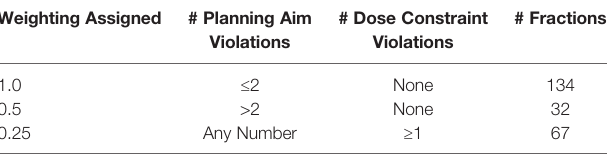
TABLE 1 | Treatment fraction data weighting regime utilized in the model training process and the number of data points belonging to each category. Weighting Assigned